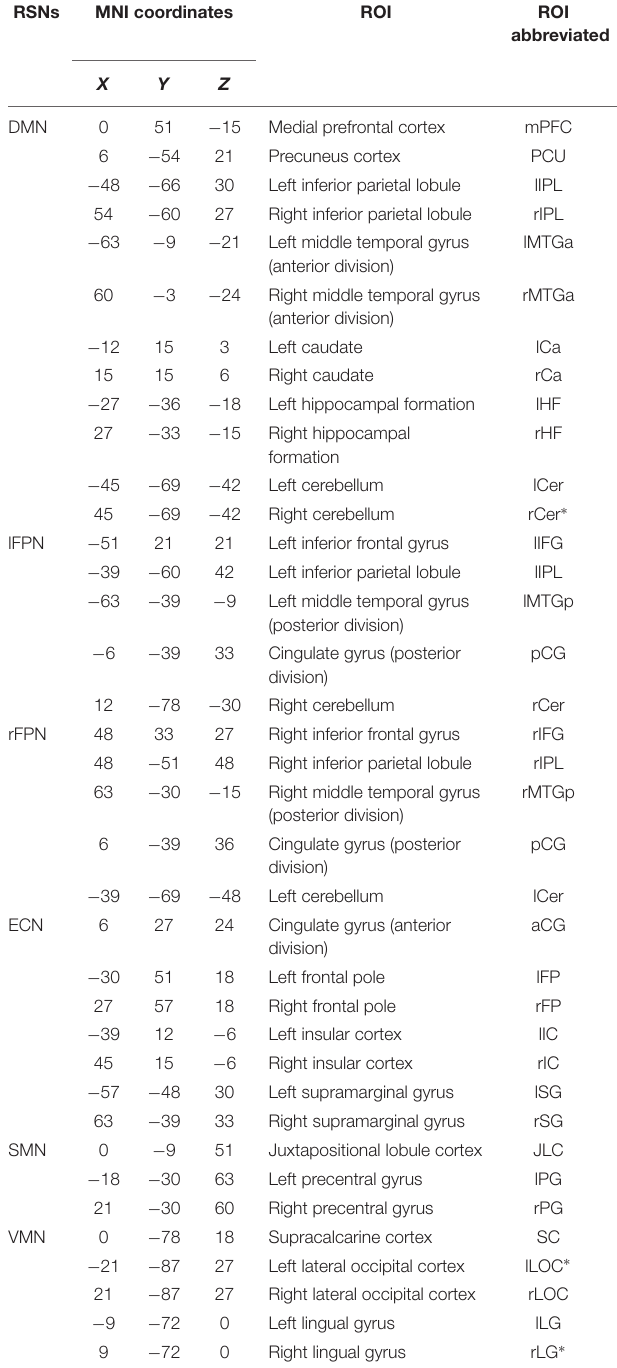
TABLE 1 | Selected networks and their respective ROIs with associated coordinates in the Montreal Neurological Institute (MNI) system. RSNs MNI coordinates ROI ROI